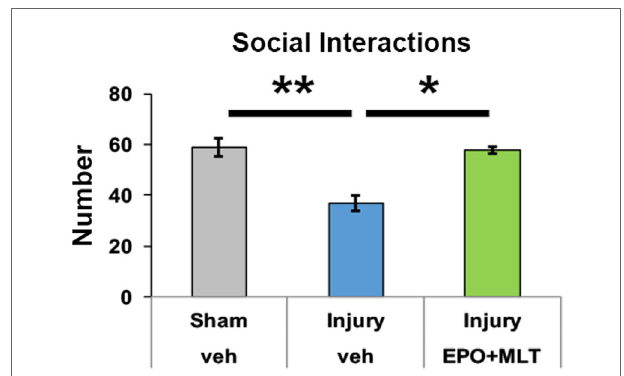
FigUre 3 | Prenatal injury impairs social interaction. After prenatal injury, pairs of vehicle-treated rats of the same sex but different litters have fewer social interactions than pairs of shams, or pairs of erythropoietin (EPO) + melatonin (MLT)-treated injured rats (two-way ANOVA with Bonferroni correction, * p < 0.05, ** p <